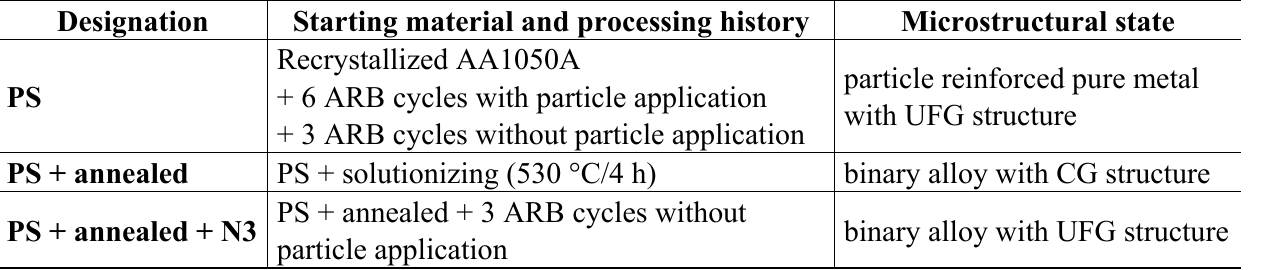
Table 2. Designation of materials, their processing history and microstructural states.